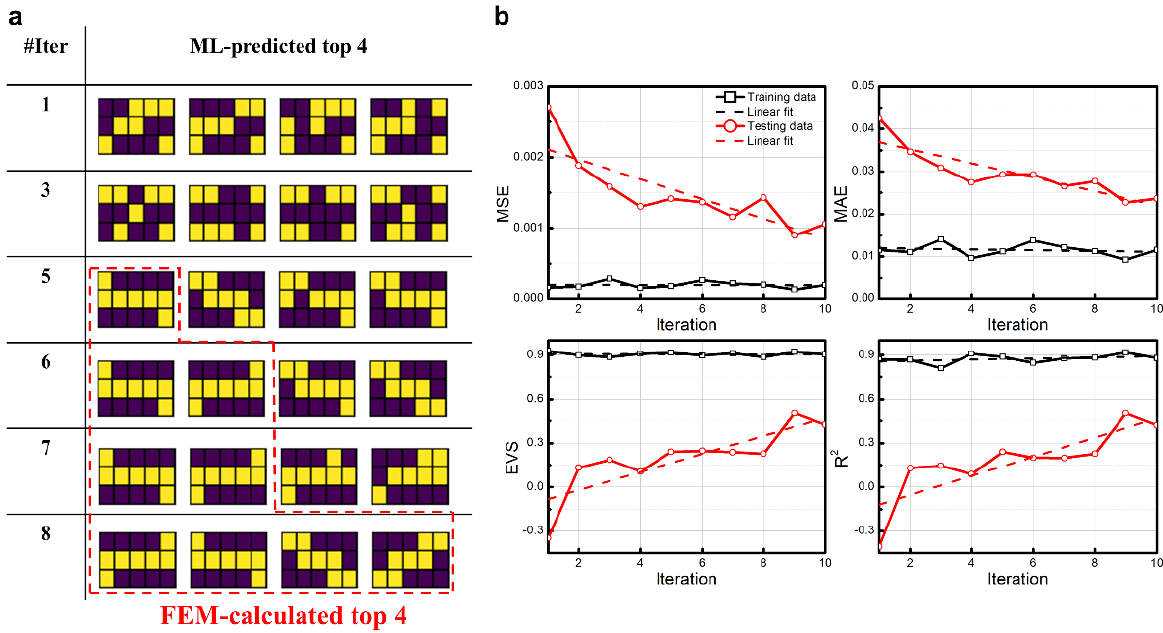
Figure 3. Iterated results and evaluations for the calculation domain discretized into 15 blocks by the proposed LSTM-based optimal strategy. ( a ) Top 4 ML-predicted sample configurations in each iteration. The sample configurations inside the red dashed-lined domain are the FEM-calculated top 4 sample configurations. ( b ) The relationship between evaluation indictors MSE, MAE, EVS, and R 2 and iteration numbers. Black curves with open rectangles are for the training dataset; black dashed lines mark average values between iterations 7 and 10. Red curves with open circles are for the testing dataset; red dashed lines mark linear fit of red curves between iterations 1 and